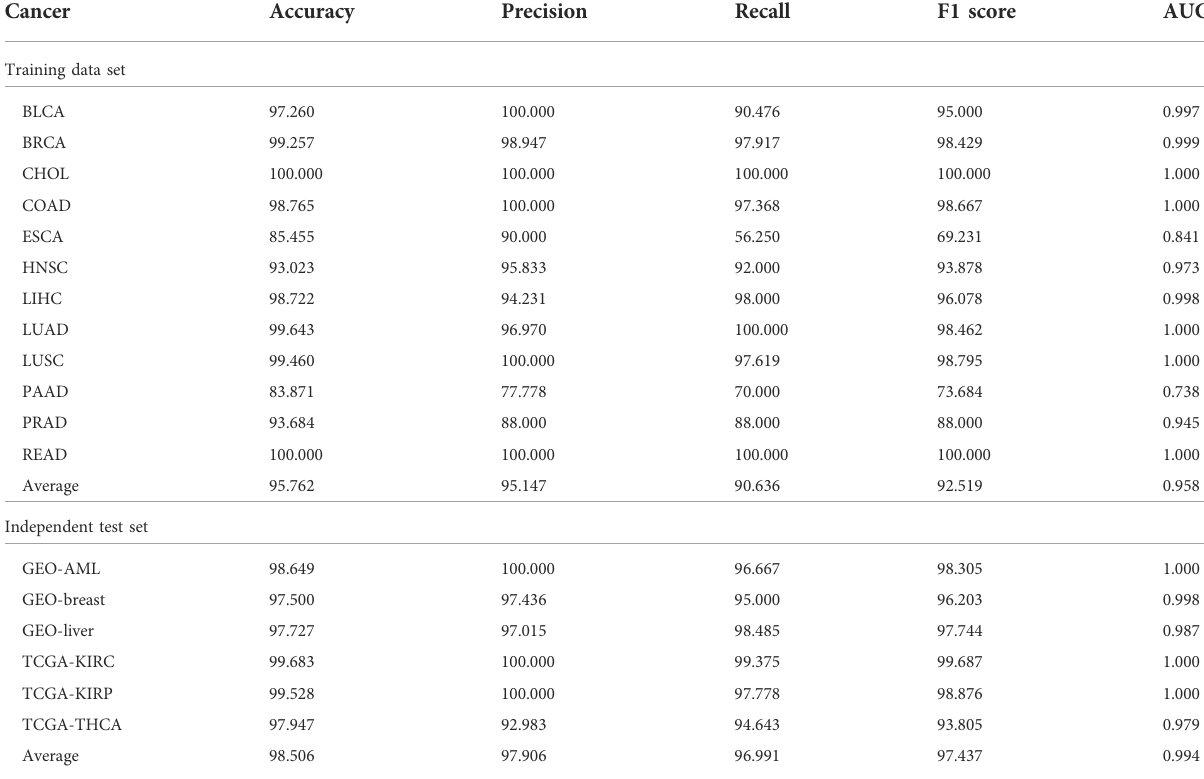
TABLE 2 Performance of the methylation loci-based diagnostic model for the training set and independent test set.